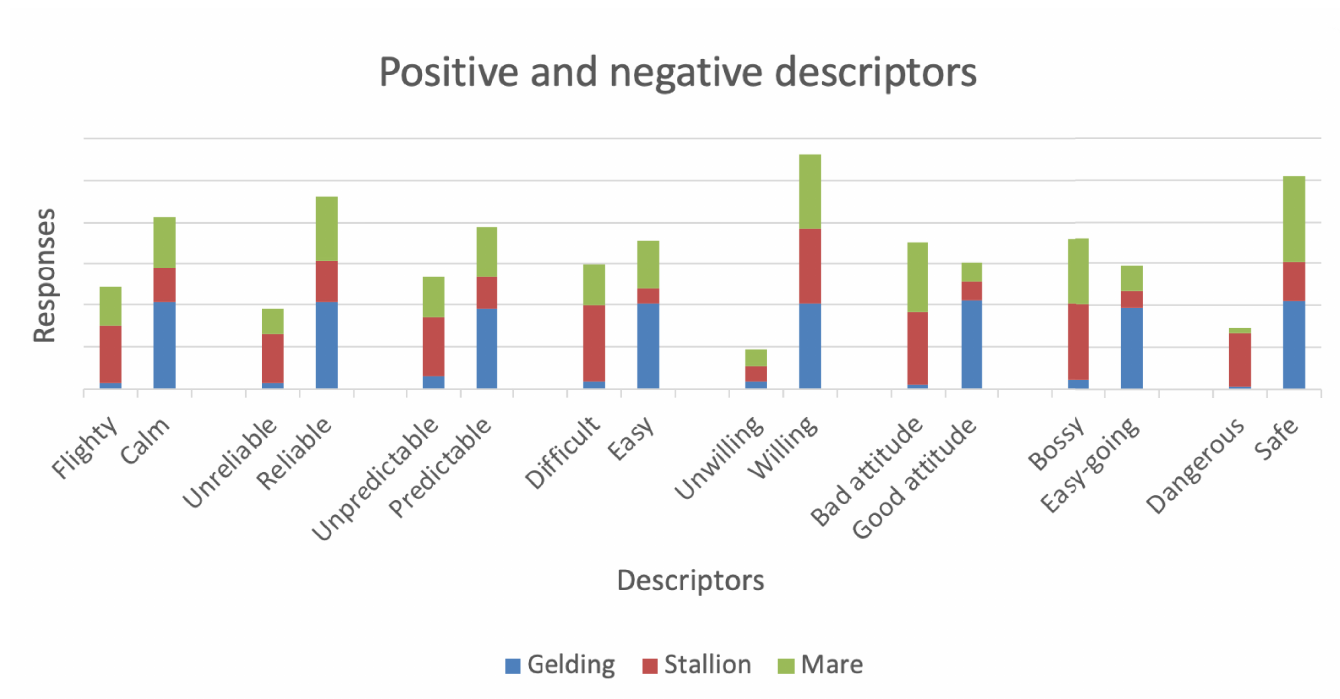
Fig 4. Positive and negative descriptors assigned to geldings, stallions and mares. More than 90% of respondents (n = 1090) allocated geldings positive descriptors. Stallions received the least positive attributes.